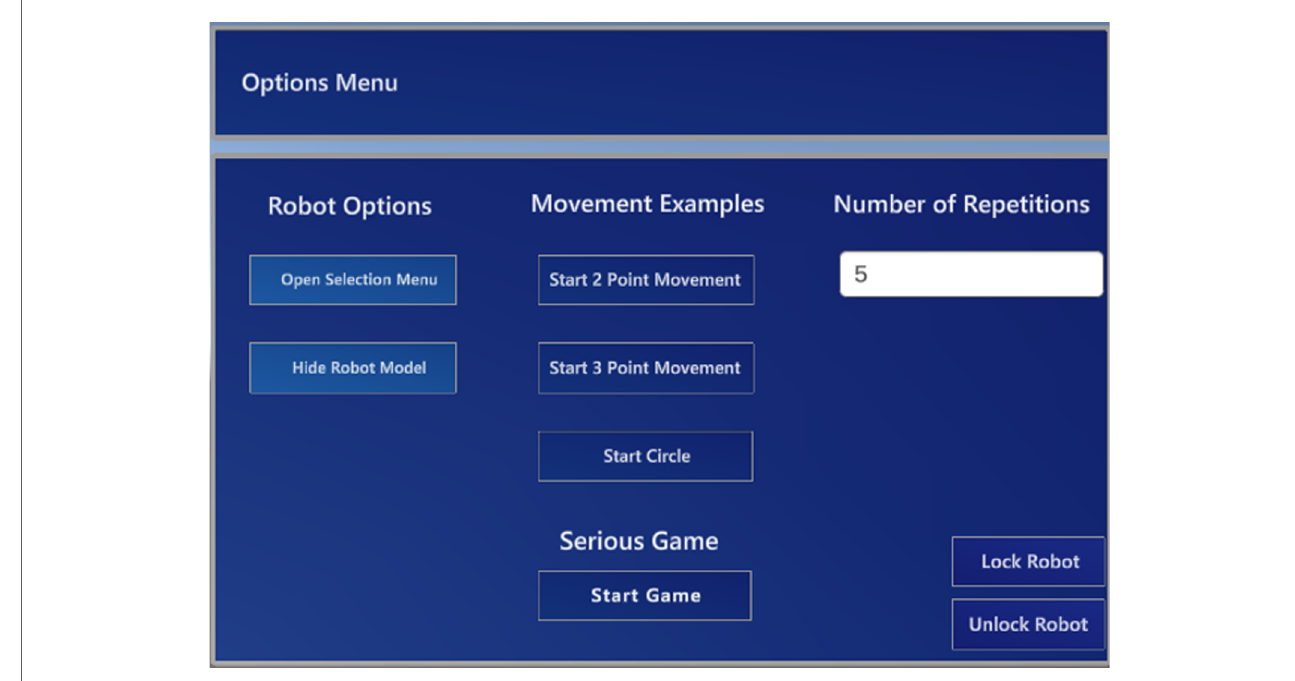
FIGURE 1 Menu for the training